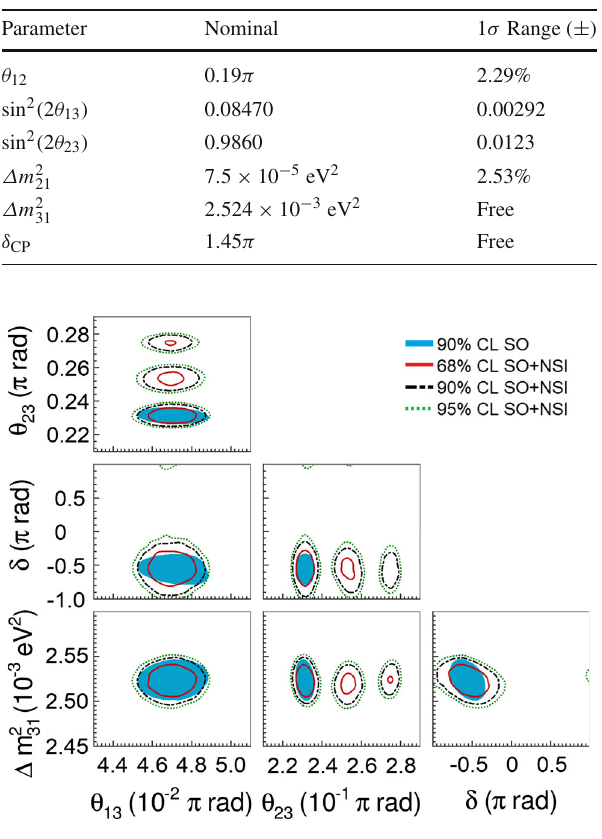
Fig. 8 Projections of the standard oscillation parameters with nonzero NSI. The sensitivity regions are for 68, 90, and 95% CL. The allowed regions considering negligible NSI (standard oscillation (SO) at 90% CL) are superposed to the SO + NSI